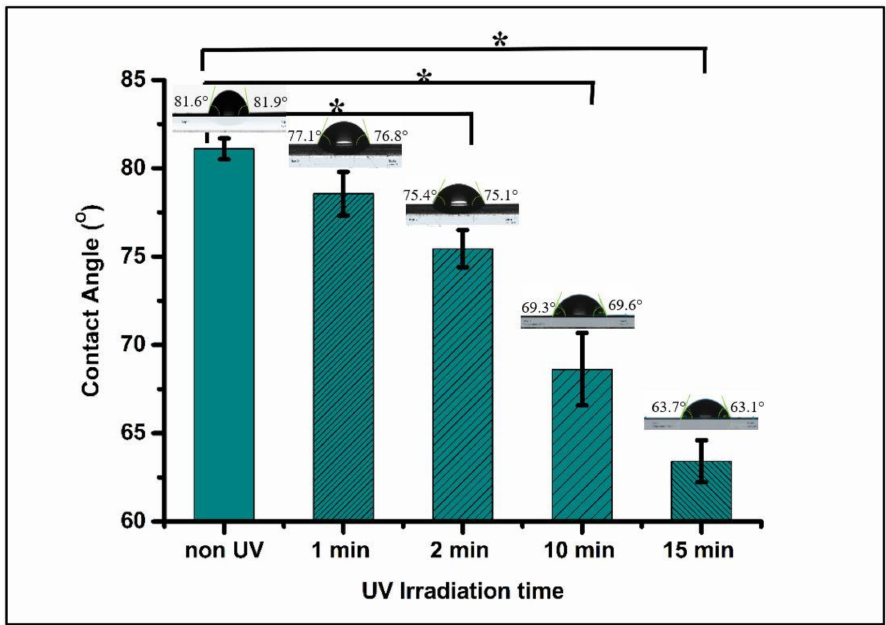
Figure 8. Water contact angle of PLA before and after UV irradiation (* means significantly different, p < 0.05).